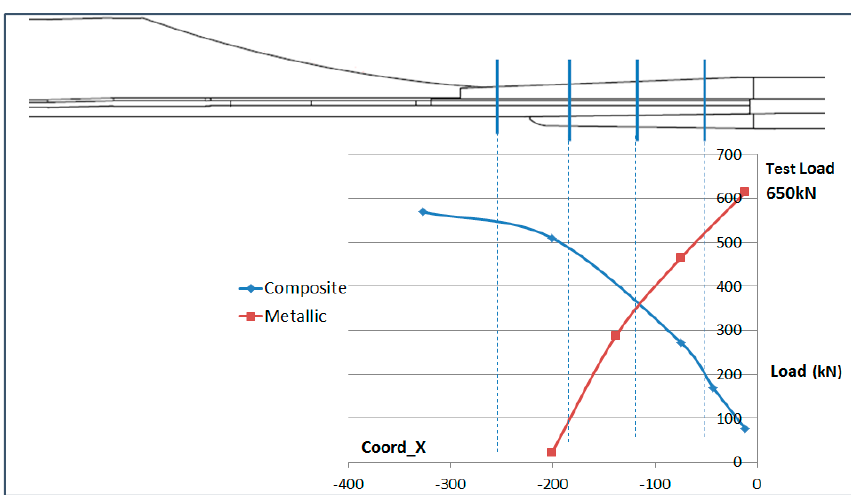
Figure 28. Load Split in Tension (650 kN).